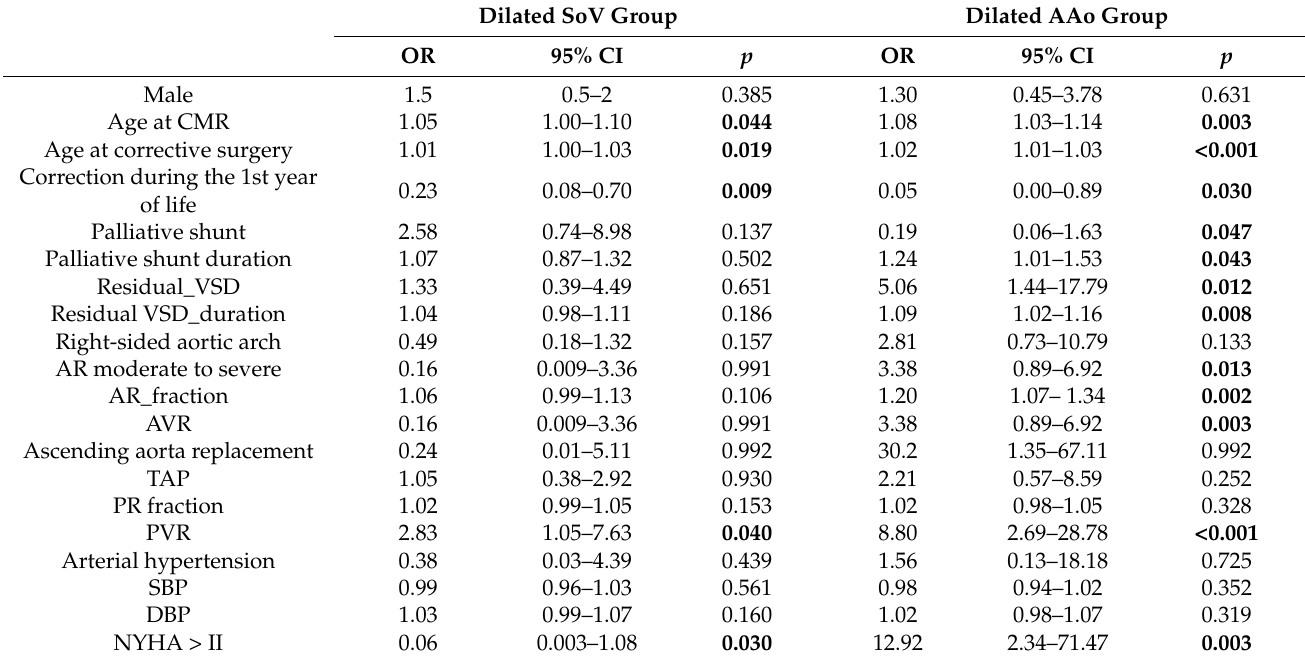
Table 3. Predictors of dilatation of sinus of Valsalva and ascending aorta by logistic regression in univariate analysis.